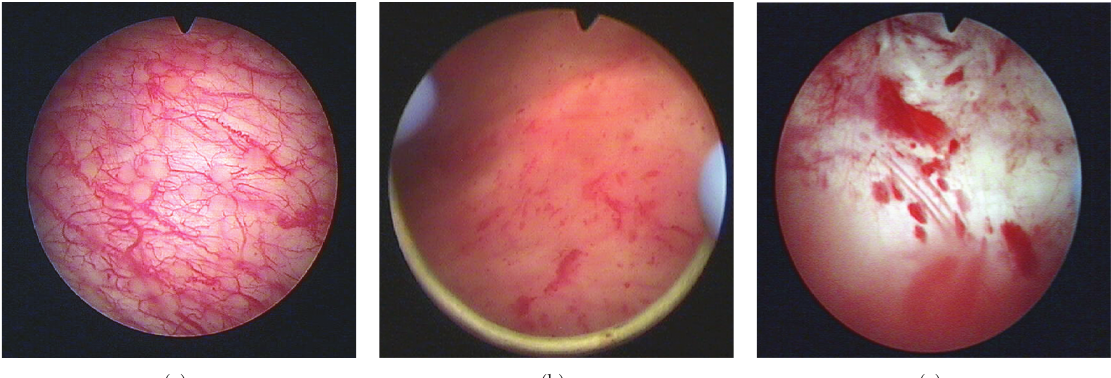
Figure 2: Cystoscopic images of patients showing identical BPS/IC symptoms. Note the heterogeneity of the appearance of the mucosa and the di ff erences in vascularization. (a) Hypervascularization of the bladder wall. (b) Atrophic bladder wall with petechial bleedings after bladder distension. (c) Ulcerative form of